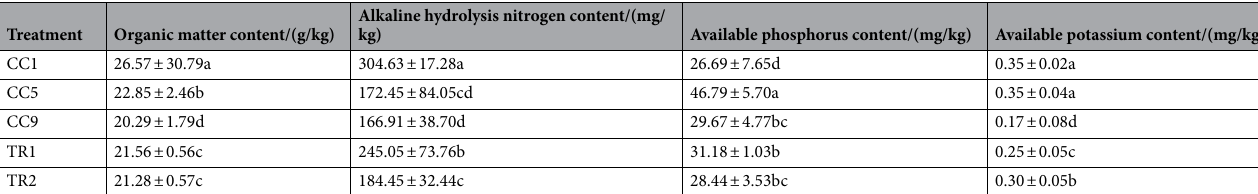
Table 2. Effects of MHT1134 on physical and chemical properties of the pepper rhizosphere soil. CC1, CC5 and CC9, represent the plots where pepper had been continuously planted for 1, 5 and 9 years, respectively, and TR1 and TR2 represent CC9 plots in which the MHT1134 biocontrol fermentation broth had been applied 1 and 2 years in advance, respectively. The data are mean ± SD. The different lowercase letters in the same column indicate significant different at P < 0.05 level by Duncan’s new multiple range test.